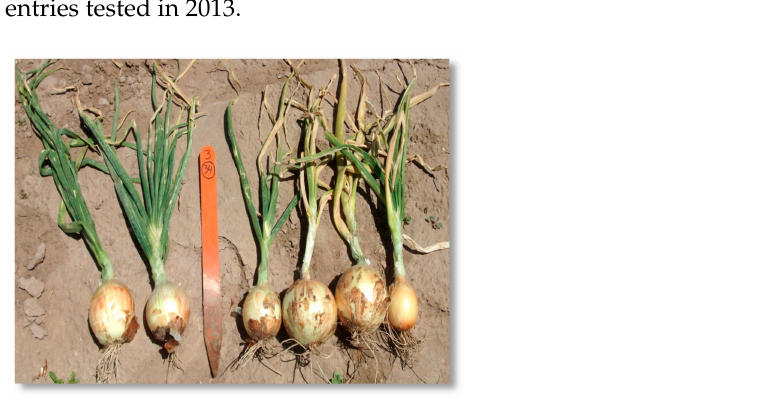
Figure 1. An example of selected plants (left of orange stake) as compared to unselected plants (right of orange stake). Plants were visually selected on the basis of less thrips damage, full bulb maturity, and mainly fewer IYS symptoms. Plants were from New Mexico State University (NMSU) breeding lines with a history of reduced Iris yellow spot